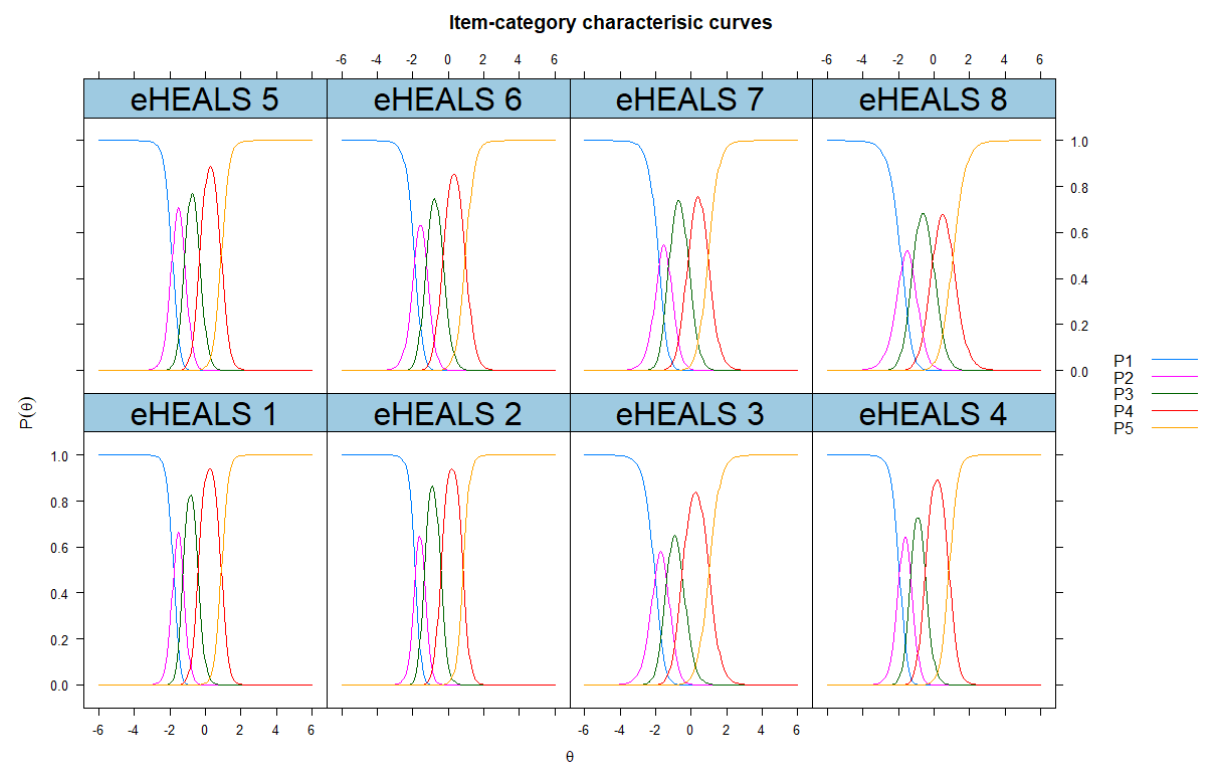
Figure 1. Item-category characteristic curves for the simplified Chinese eHealth literacy scale. eHEALS: eHealth literacy scale; P: probability of option to be selected.